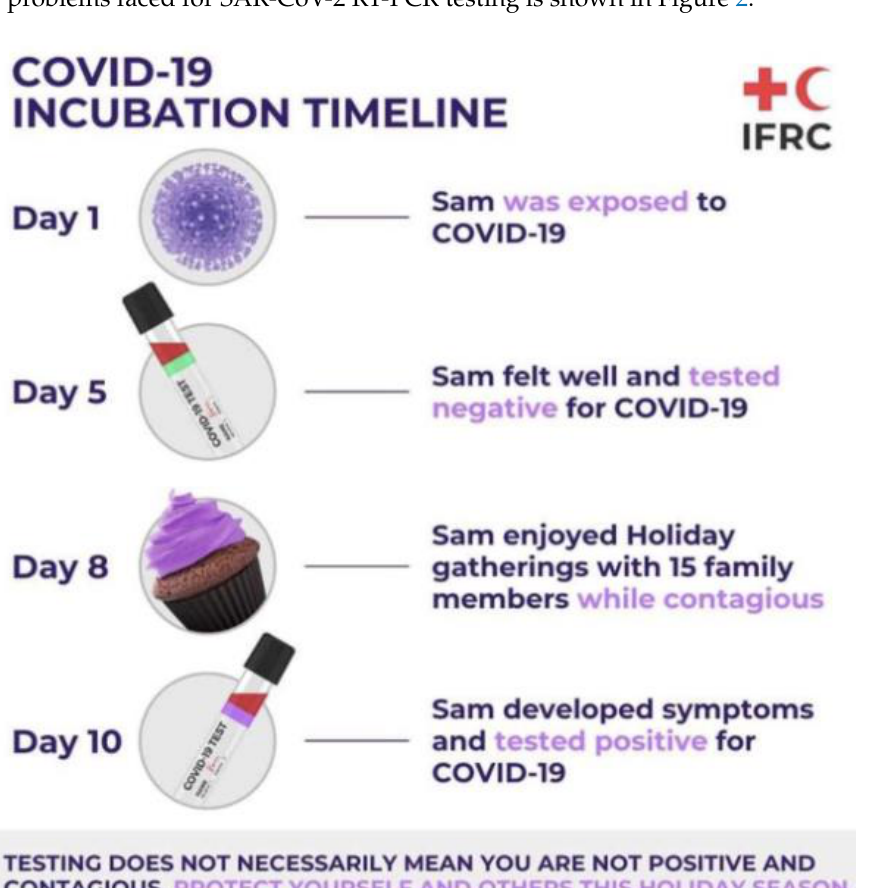
Figure 2. Illustration of a potential problem that is faced with RT-PCR testing due to difficulties in early detection of SAR-CoV-2 as described by the Red Cross [25].